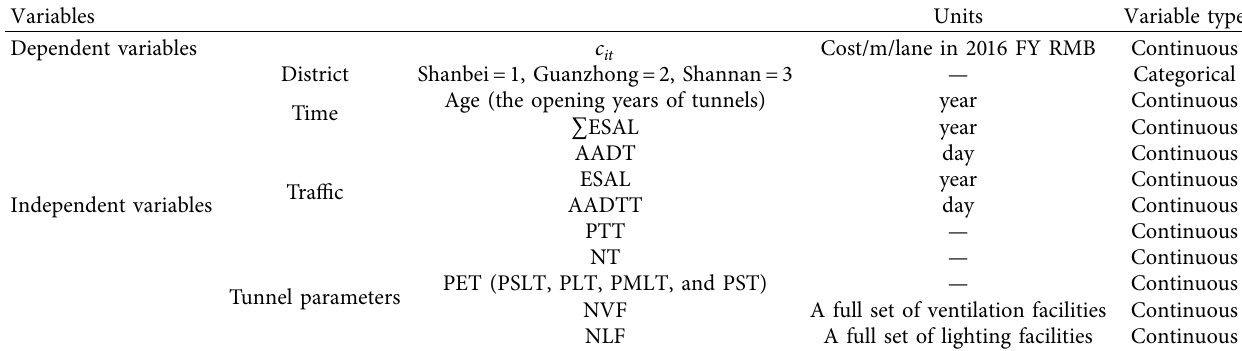
Table 1: Dependent and independent